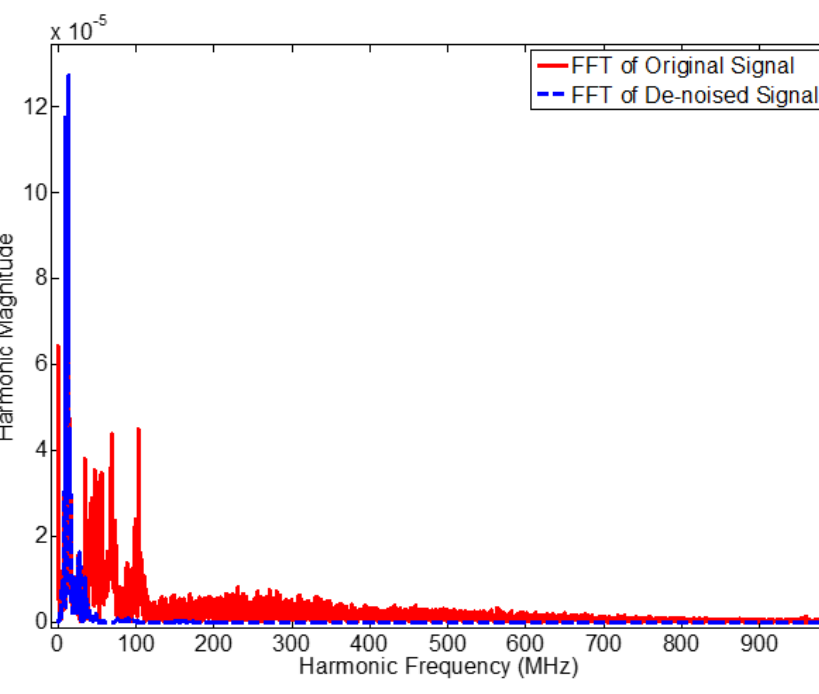
Figure 13. FFT of signal, captured by loop antenna (original vs.